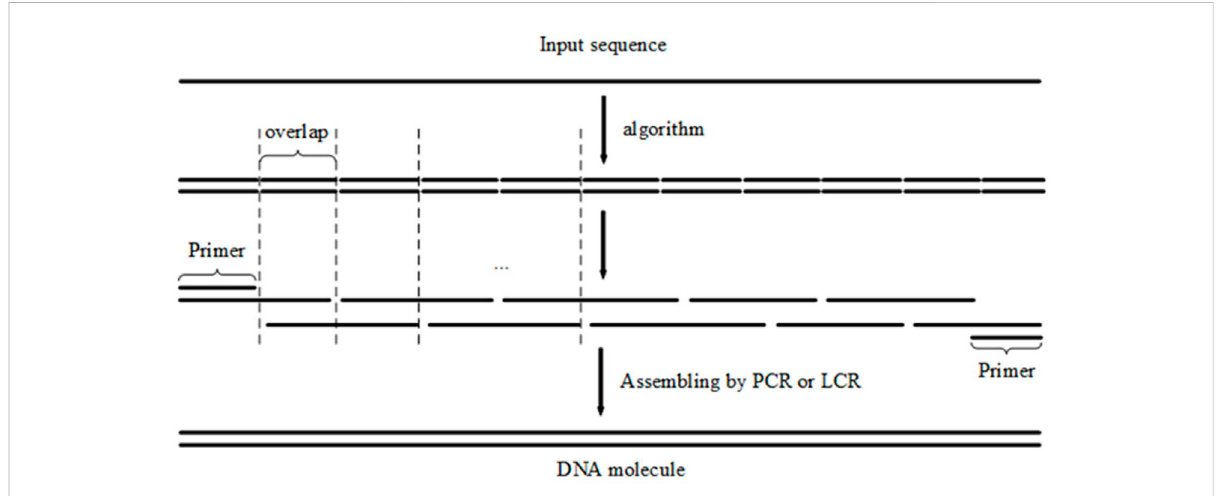
FIGURE 1 When assembling oligonucleotides with PCR or LCR, the overlapped regions of oligonucleotides are connected sequentially by the input sequence. The ‘ Primer ’ in the fi gure indicates that the primers for PCR share the same sequence with fi rst and last